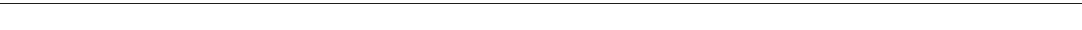
Fig. 10 Upregulation of UBR5 suppresses polyQ-expanded HTT aggregation. a Filter trap analysis with anti-polyQ-expansion diseases marker antibody